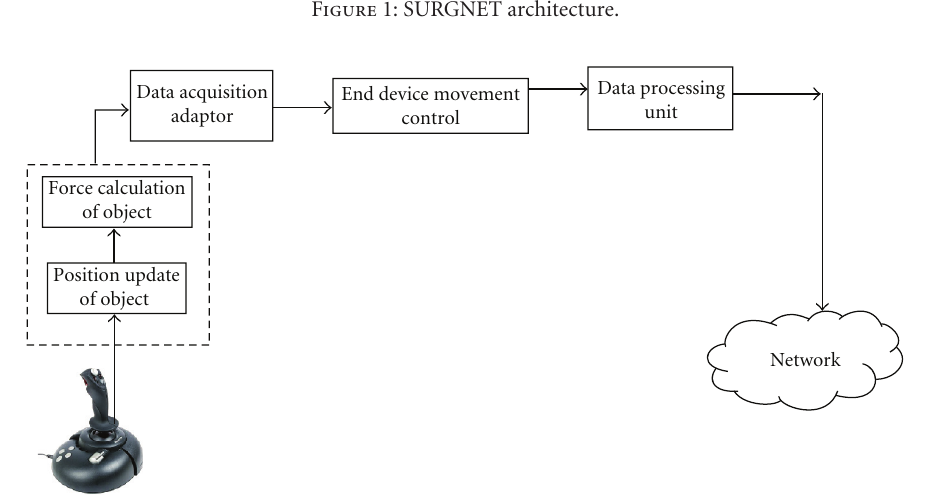
Figure 2: Server functional